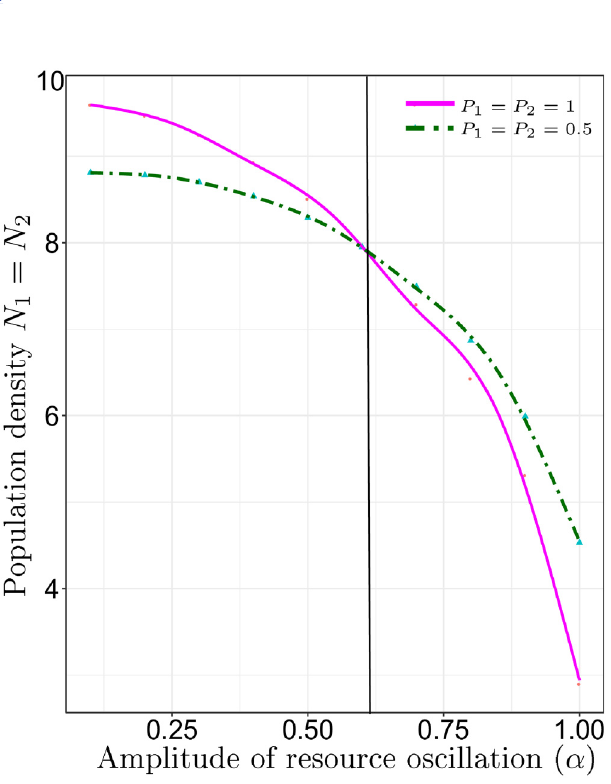
Fig 5. Maximum population density at which foragers can maintain a consistent diet that meets the target of h over 50 years when partitioned ( p 1 = p 2 = 1, solid magenta line) and when mixed ( p 1 = p 2 = 0.5, green-dashed-dot line). In high amplitude environments, migration between habitats has a higher maximum density than no migration, and in low amplitude environments, the opposite is true.